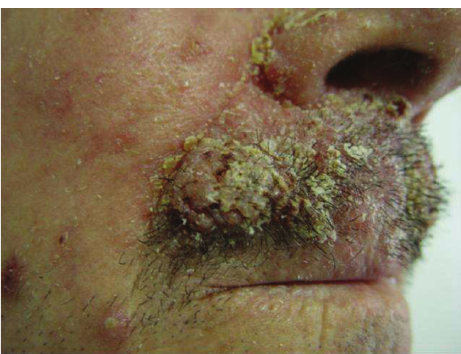
Figure 1: Nodular lesions located on the upper lip.